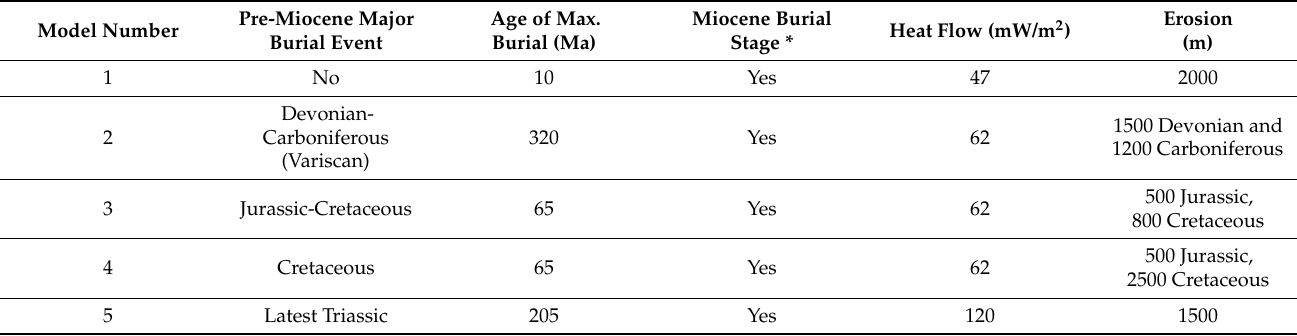
Table 1. Basic assumption in the analyzed